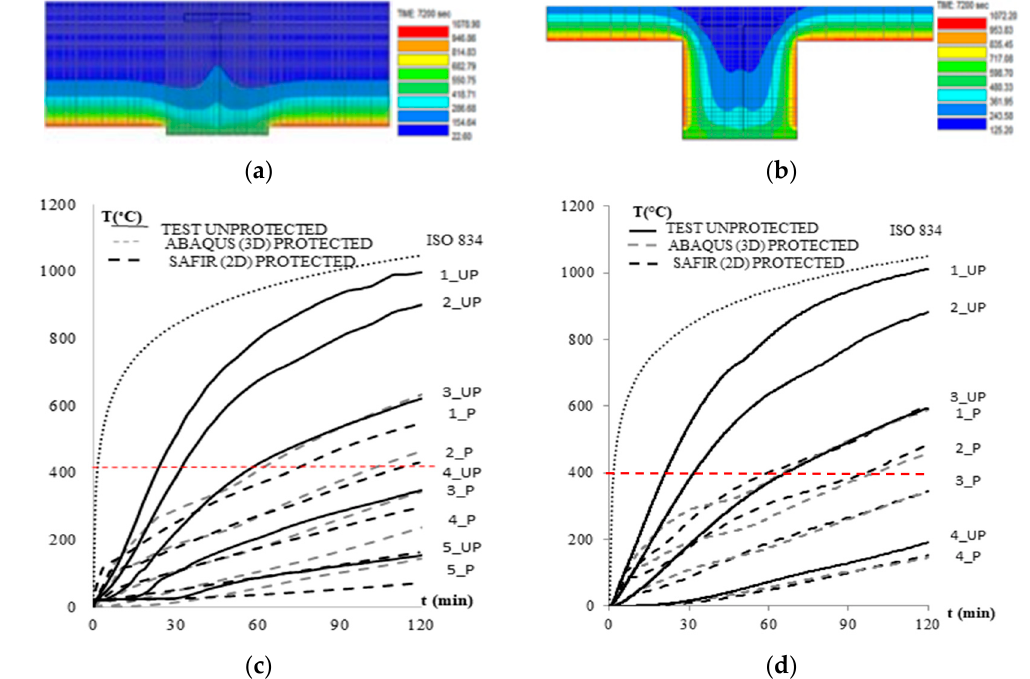
Figure 10. Effectiveness of IC in terms of temperatures predictions for protected vs. recorded for unprotected, WFRC 66162: ( a ) Thermal contours for the protected beam at section AA’ after 120 min, ( b ) Thermal contours for the protected beam at section BB’ after 120 min, ( c ) Protected vs. Unprotected at section AA’ ( d ) Protected vs. Unprotected at section BB’.